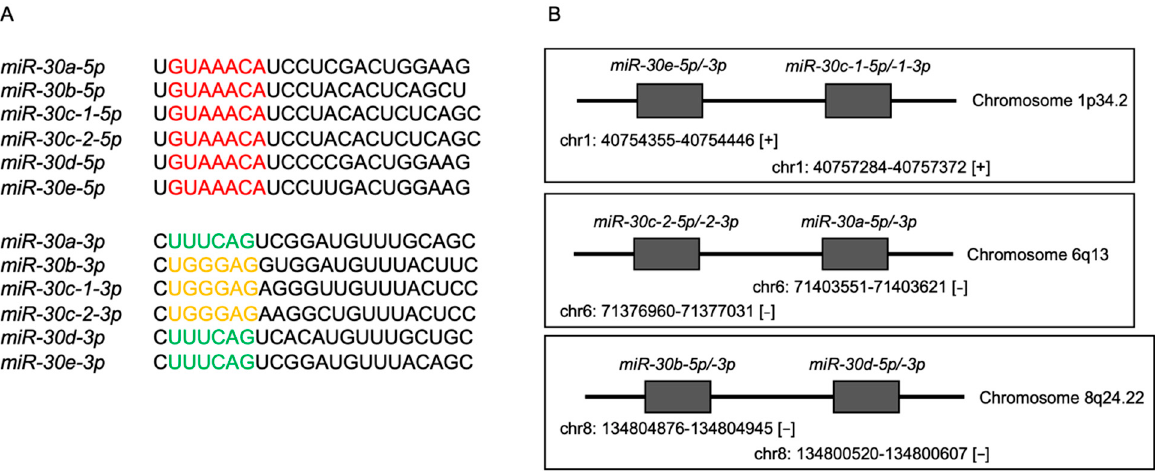
Figure 1. Twelve miRNAs are present in the human genome as members of the miR-30 family. ( A ) Seed sequences of miR-30-5p are identical. In contrast, two types of seed sequences are present in miR-30-3p . ( B ) The locations of each microRNA family on chromosome. Expression levels of all members of the miR-30 family were validated by TCGA database analyses. All members of the miR-30 family (except for miR-30c-5p ) were significantly downregulated in HNSCC tissues ( n = 484) compared to normal tissues ( n = 44) (Figure 2).